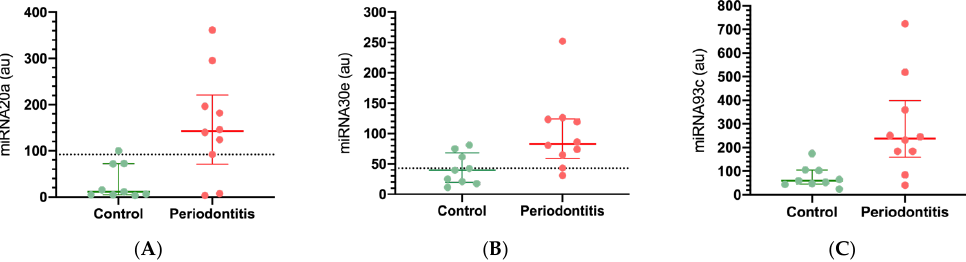
Figure 1. The miRNA-20a, miRNA-30e, and miRNA-93 expressions were upregulated in periodontitis tissues ( A ) miRNA-20a expression ( p = 0.028); ( B ) miRNA-30e expression ( p = 0.035); ( C ) miRNA-93c expression ( p = 0.026). (au): arbitrary units. The relative miRNAs expressions were determined by qRT-PCR and normalized with U6. A suggested threshold of the periodontitis condition is suggested by a dotted lin.